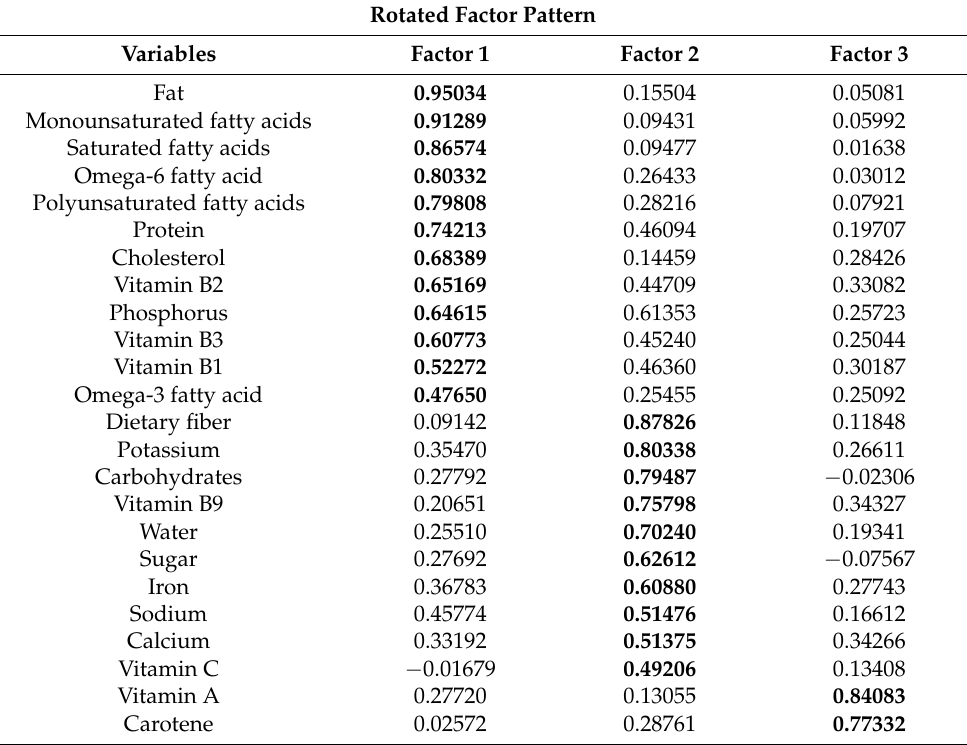
Table 4. Results of factor rotation. Factor analysis is a method used to describe unobserved variables for reducing dimensions by analyzing correlations between observed variables. After performing the factor analysis, the results were obtained by rotating the factors to facilitate the